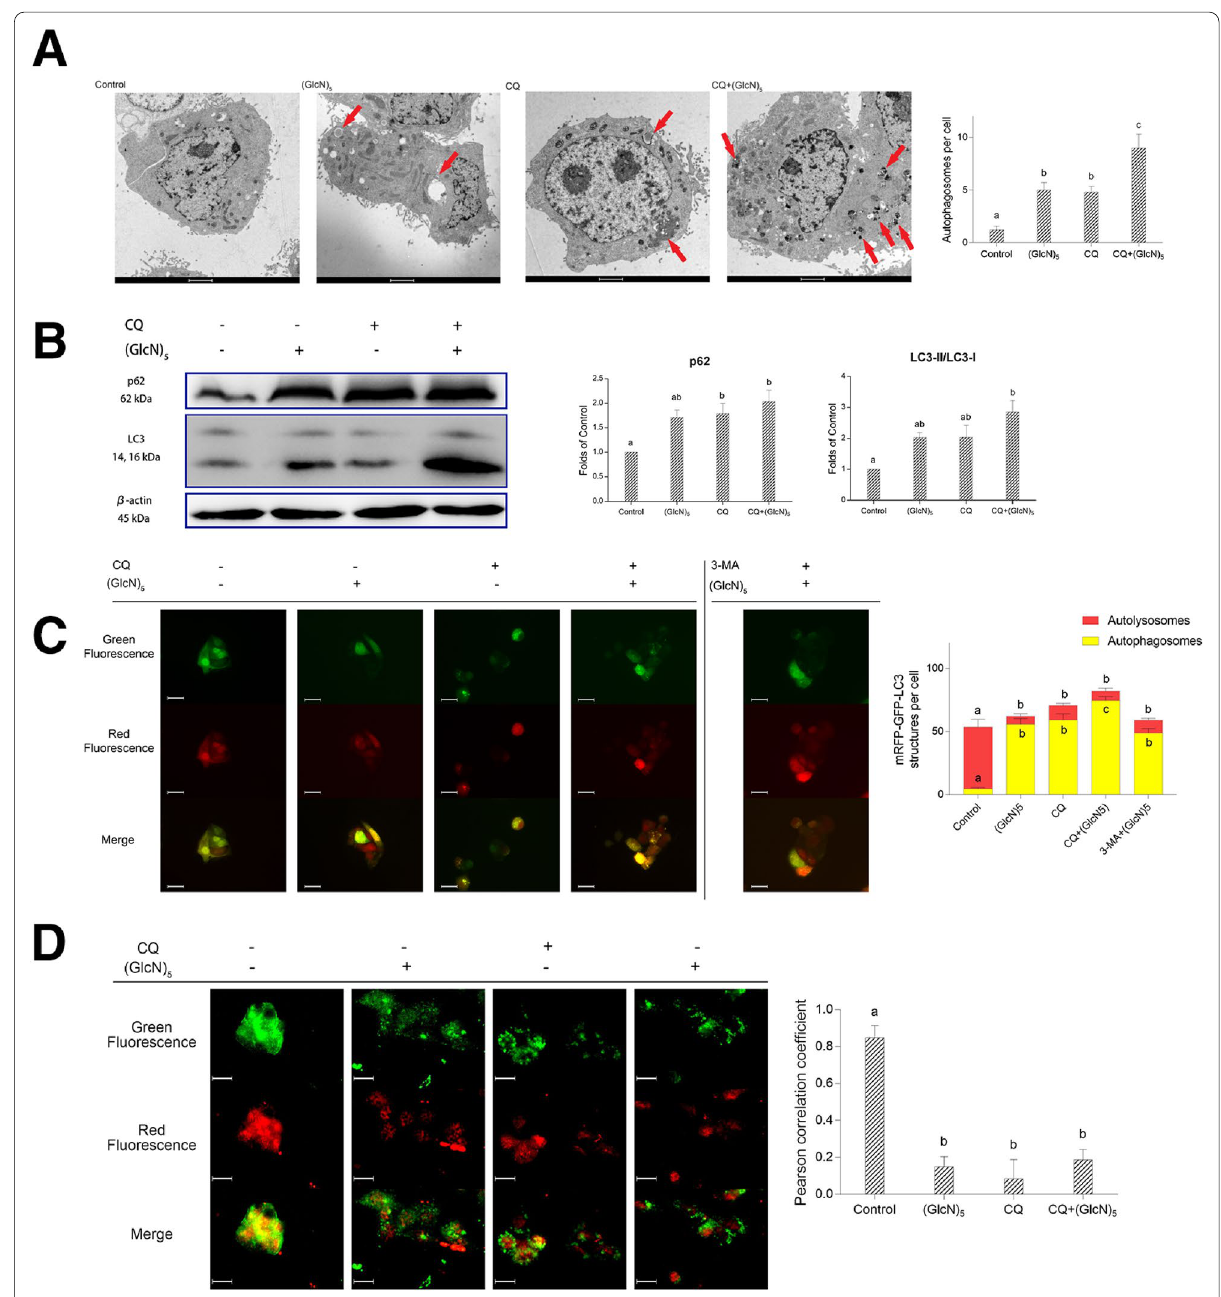
Fig. 6 (GlcN) 5 suppressed autophagy flux. A TEM results. Scale bar represents 2 μm. Autophagosomes per cell were counted and quantified. B Western blot analysis for p62 and LC3B. C LC3 puncta detection through transfection of mRFP-GFP-LC3. Scale bar represents 50 μm. LC3 puncta per cell were counted and quantified. D Colocalization analysis for autophagosomes and lysosomes. Scale bar represents 50 μm. Cells were treated with or without (GlcN) 5 (5 mM), CQ (5 μM), or 3-MA (5 mM). Data were represented as mean SD Significance between groups was marked by various ± letters, a, b, c, etc. (One-way